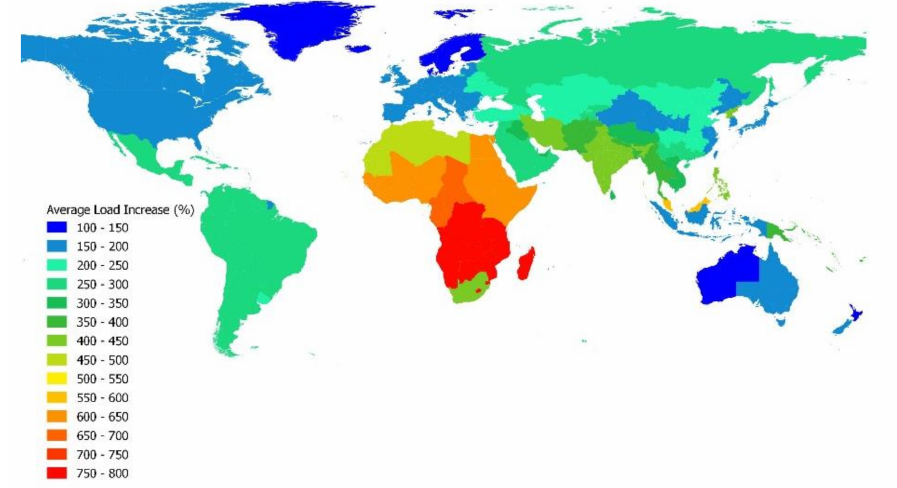
Figure 4. Increases in the average calculated load by 2050 in 72 regions under the 1.5 ◦ C Scenario, in percentages relative to 2020. The average load was calculated across 8760 h per year. The regional ratios between the maximum and minimum loads vary significantly. ‘Residual load’ in this analysis is the load remaining after the generation of variable renewable power. Negative values indicate that the power generated from solar and wind exceeds the actual load and are exported to other regions, stored, or curtailed. The residual load varies significantly with increased variable generation because maximum load and maximum generation do not occur